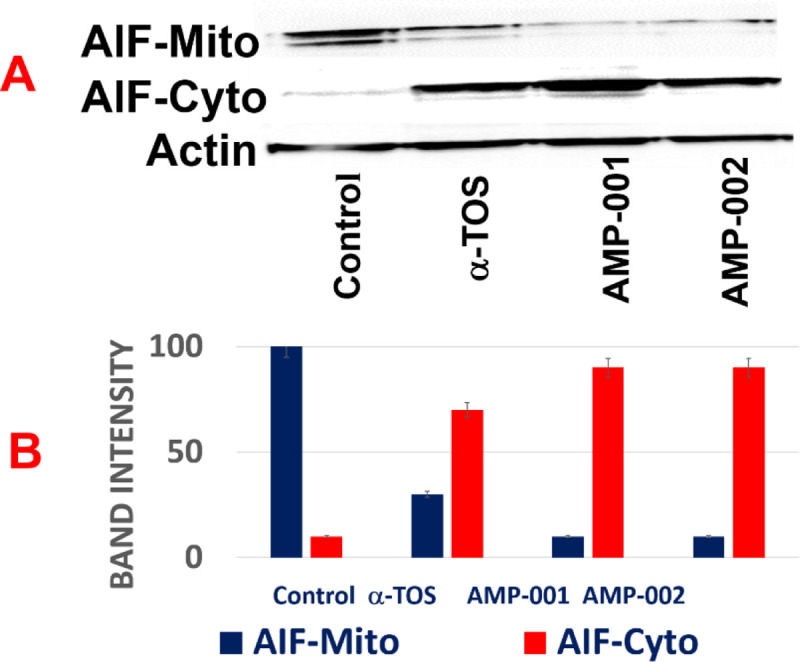
“Treatment with AMP-001/002 causes release of mitochondrial AIF-1 (Mito) into the cytoplasm (Cyto)”.TNBC MDA-MB-231 cells were treated with AMP-001/002 (30 μM), or positive control α-TOS (60 μM) and protein levels of AIF-1 were assessed in mitochondrial and cytoplasmic cellular fractions with Actin as a reference control (A). AIF-1 levels are quantified in bar graph (B), N = 5, p < 0.006.